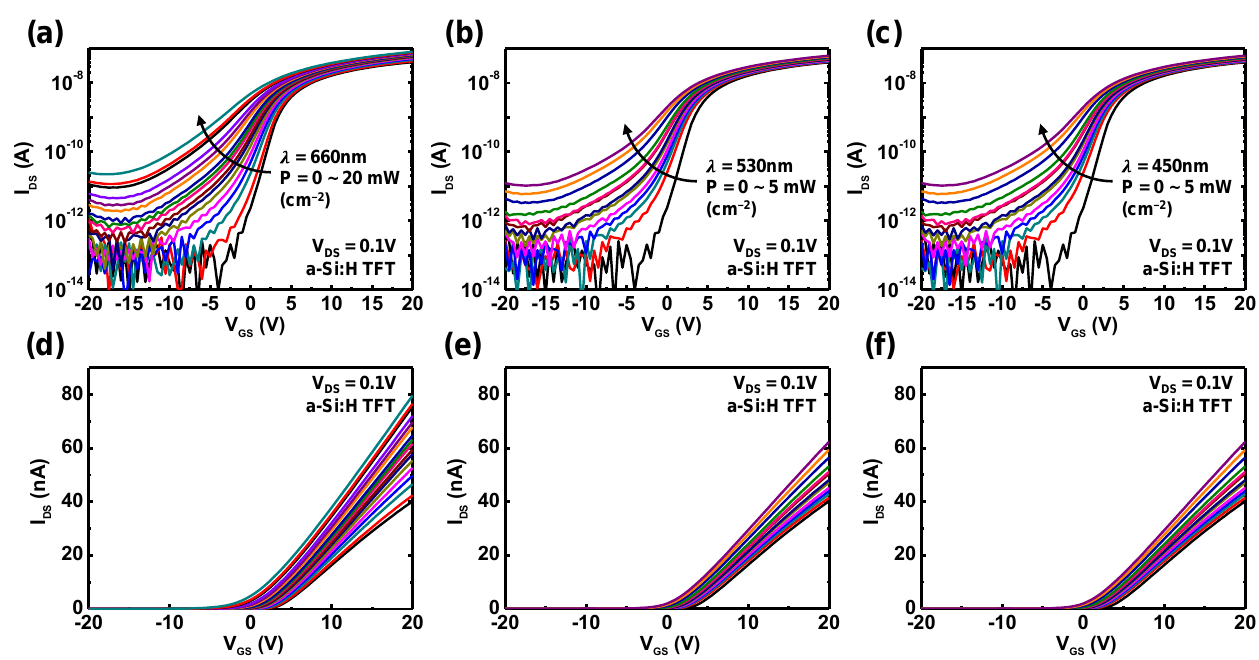
Figure 2. Transfer characteristics of a-Si:H TFTs under illumination of 660, 530, and 450 nm lasers in ( a – c ) log and ( d – f ) linear scale. Various optical intensities (0~5 mW cm – 2 ) were applied to a-Si:H TFTs with the same distance and angle.